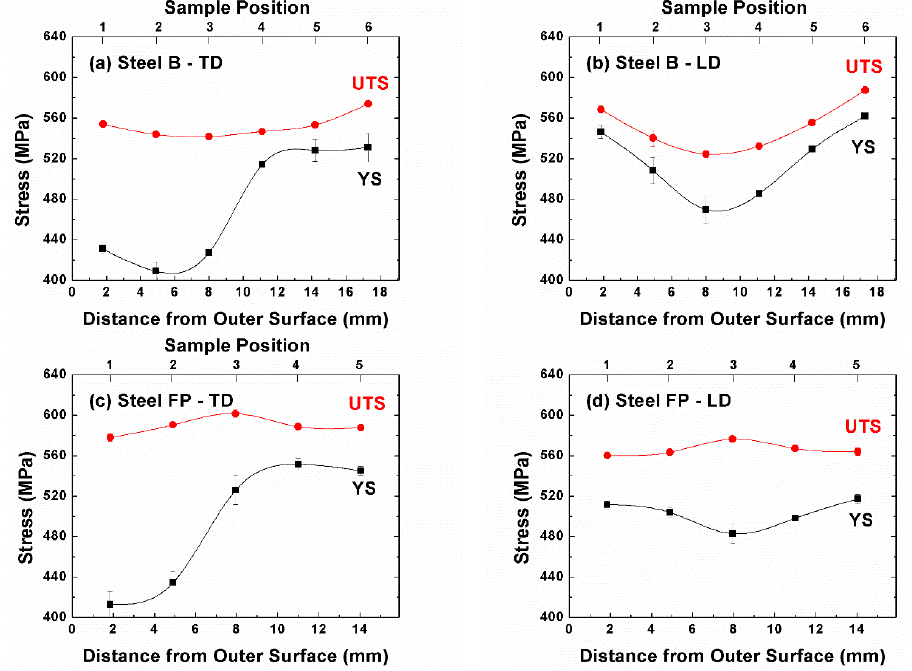
Figure 6. Yield strength (YS) and ultimate tensile strength (UTS) for steel B and steel FP obtained in the transverse direction (TD) and the longitudinal direction (LD) after flattening. ( a ) steel B-TD, ( b ) steel B-LD, ( c ) steel FP-TD and ( d ) steel FP-LD.